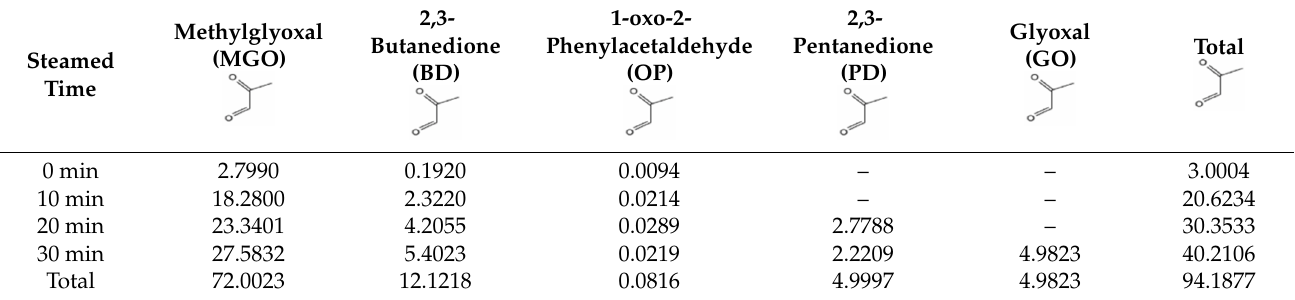
Table 2. Species and relative content of α -DCs in experimental simulation system ( μ g/g).